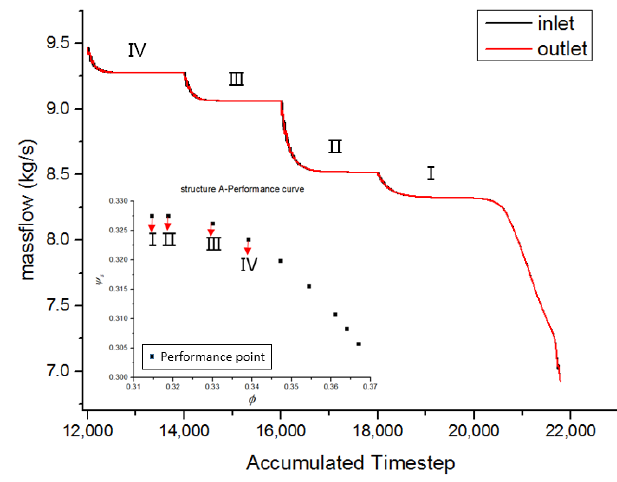
Figure 4. Monitoring of curves during steady simulation.